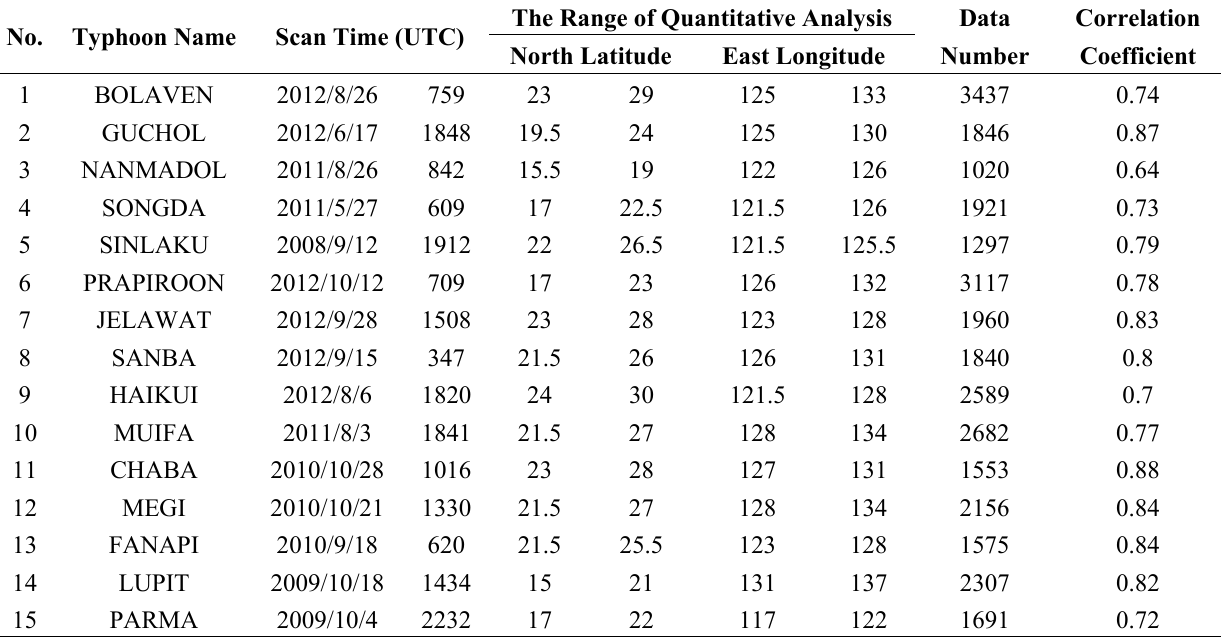
Table 3. Information on the simulated